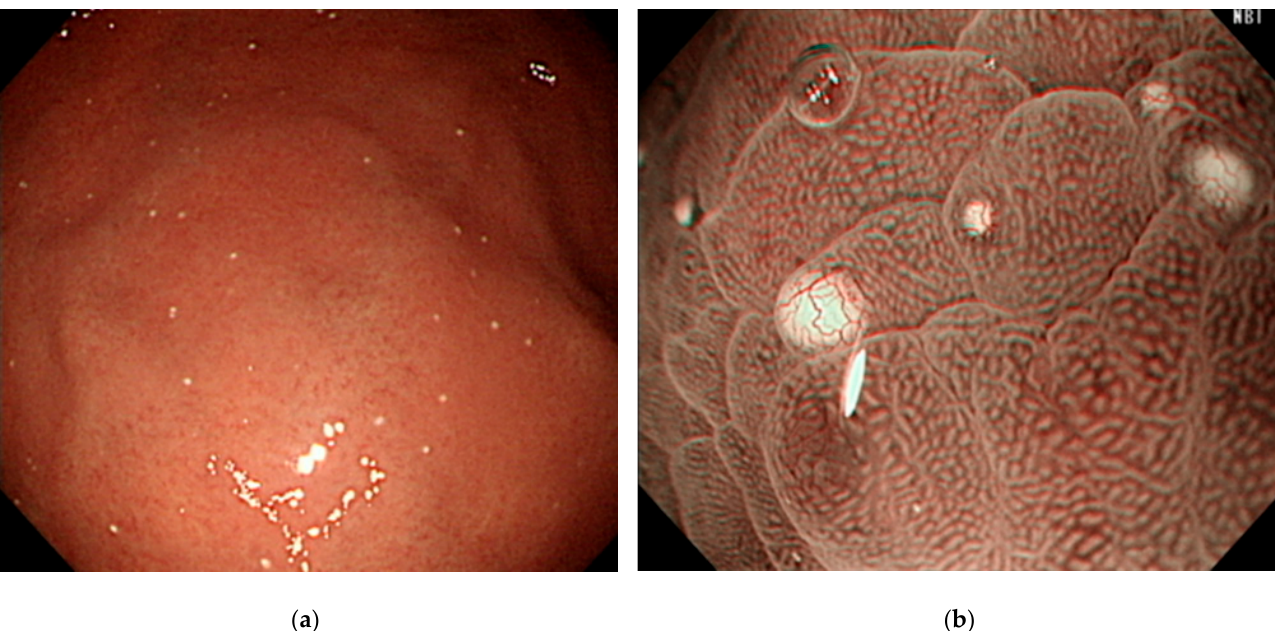
Figure 1. Endoscopic images: ( a ) multiple, round, slightly elevated, white substances are observed on white-light imaging; ( b ) magnifying narrow-band imaging reveals the presence of microvessels overlying the white lesion with a globular shape.